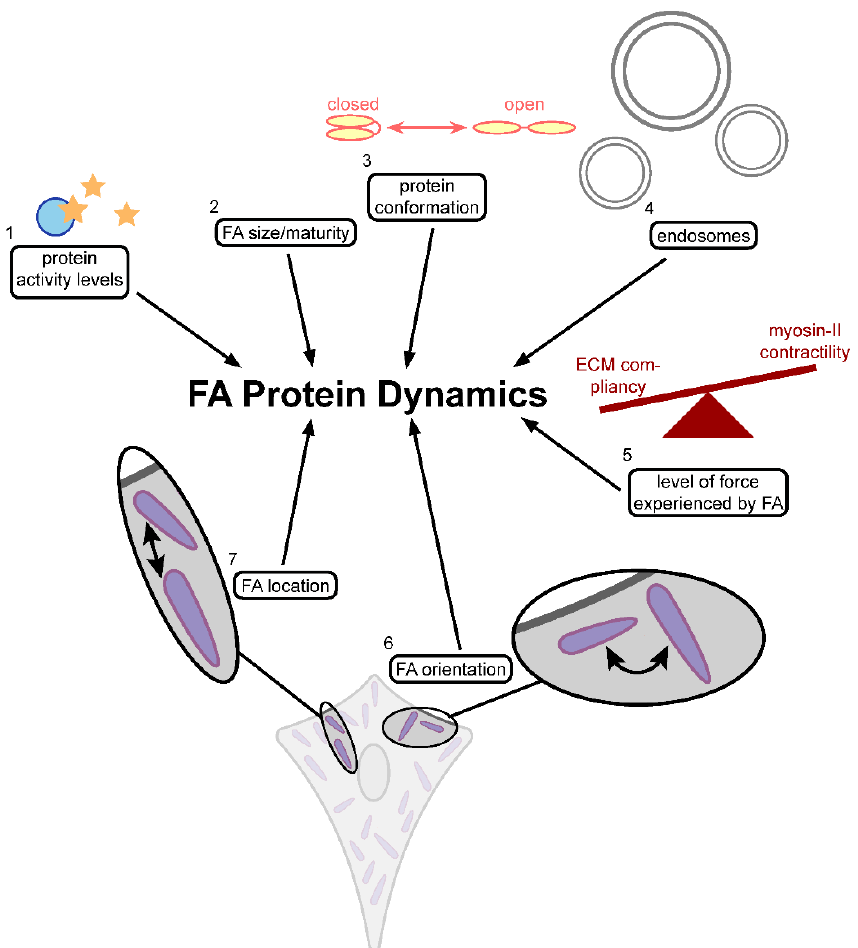
Figure 8. Factors reported to impact focal adhesion protein-binding dynamics. Schematic illustration of the diverse factors reported to correlate with focal adhesion protein-binding